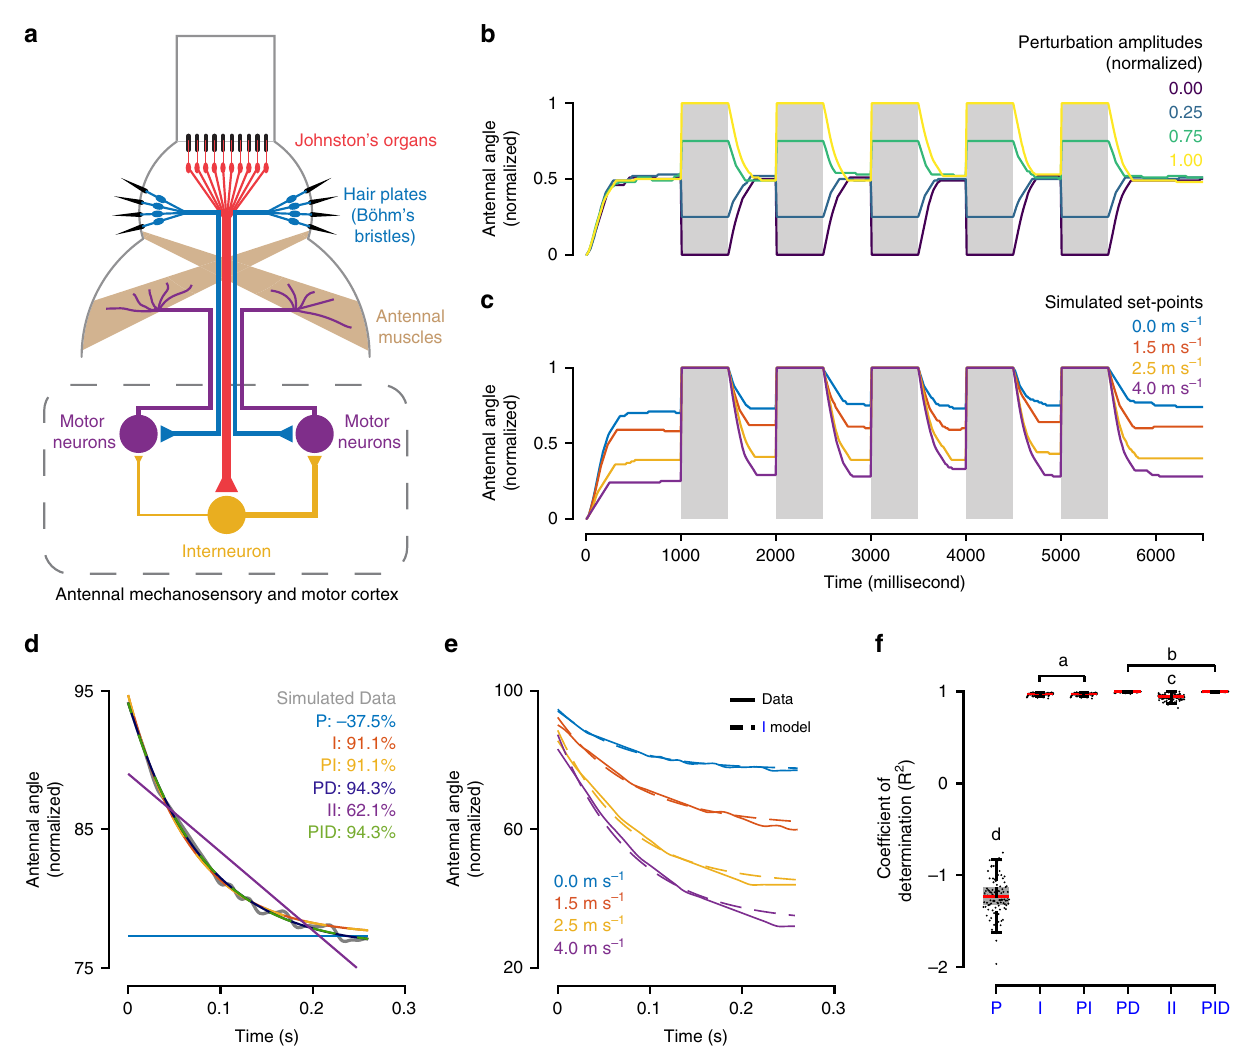
Fig. 5 A model neural circuit for air fl ow-dependent antennal positioning. a Model neural circuit . Motor neurons summate activity from mechanosensory neurons from Böhm ’ s bristles and interneurons transmitting sensory inputs from the JO. The connectivity between the motor neuron and the muscles give rise to the negative feedback in Fig. 2a; motor neurons activate muscles which, upon contraction, reduce feedback from the hair plates, thereby decreasing their own activity. Muscles, due to the slow calcium integration times, integrate error in position. Sensory inputs from JO asymmetrically activate the motor neurons, thereby modulating antennal set-point. b Simulated antennal positioning re fl ex. Simulation of the model in Fig. 4a using NEST simulator without any set-point modulation. The simulation protocol was the same as in experiments. Simulated antennae corrected their positions to the intrinsic set-point of the neural circuit. Different colours represent different levels of perturbation. c Set-point modulation of the antennal positioning re fl ex . Set-point was modulated by asymmetric excitation of the motor neurons. The simulated antennae were corrected and maintained at different positions based on excitation by the interneuron. Different colours represent different modulations of the intrinsic set-point. d – f Control theoretic analysis of the simulated antenna. d Fits of all six models on the return trajectory of the simulated antenna. Four models — I, PI, PD, PID — fi t the representative simulated antennal trajectory well (>80% fi t). The integral model (I) was the most parsimonious of them. e Fits of the integral model on return trajectories for different set- points. f Box-and-Whisker plots of coef fi cient of determination ( R 2 ) for all system models (a – d represent statistically different groups, Kruskal – Wallis, Nemenyi test, p < 0.01; n = 100 trajectories; median values of R 2 — P: − 1.23, I: 0.97, PI: 0.97, PD: 1.0, II: 0. 94, PID: